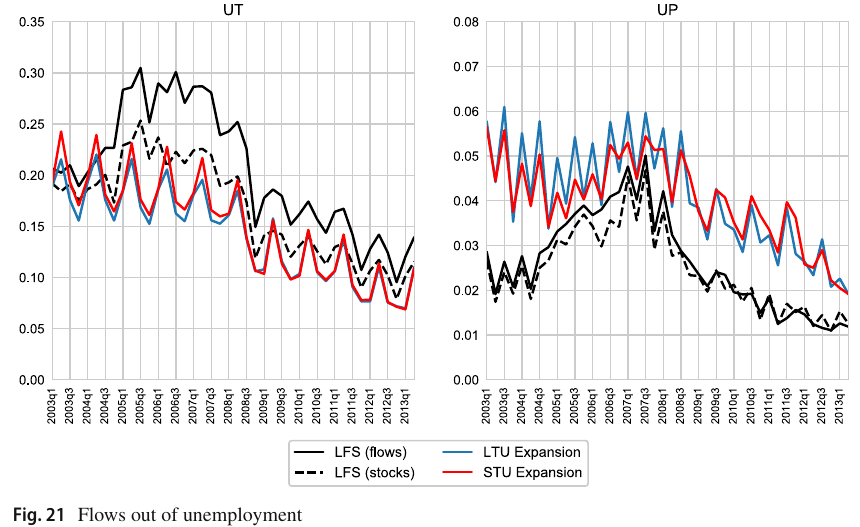
Fig. 21 Flows out of unemployment